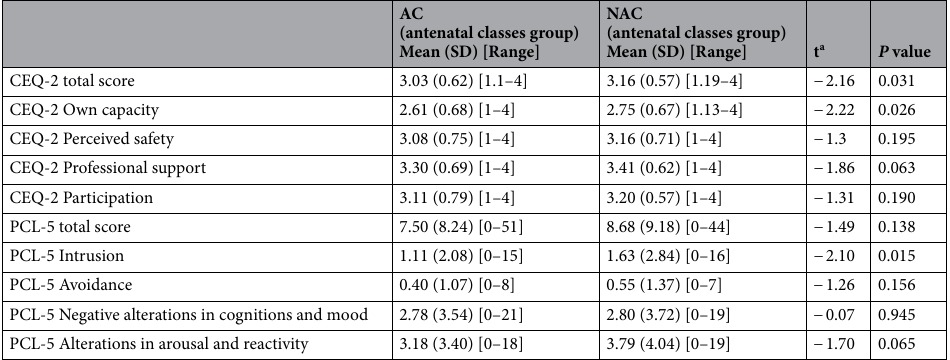
Table 2. Results of PCL-5 and CEQ-2 according to antenatal class attendance. a Independent sample t test.